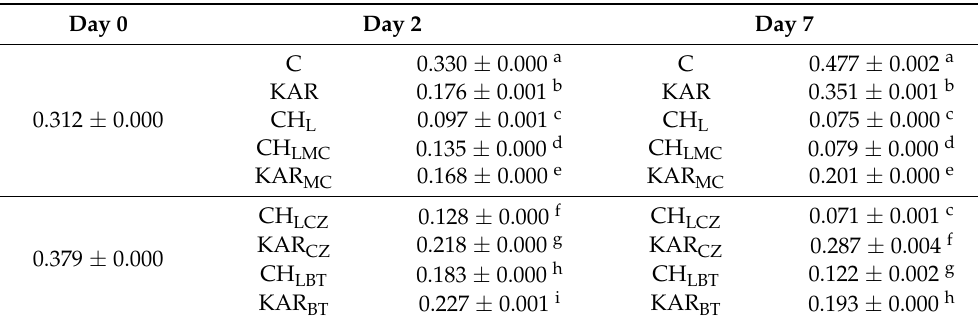
Table 6. TPC (expressed as mg gallic acid/g) of Golden Delicious apples packaged in prepared film forming solutions.